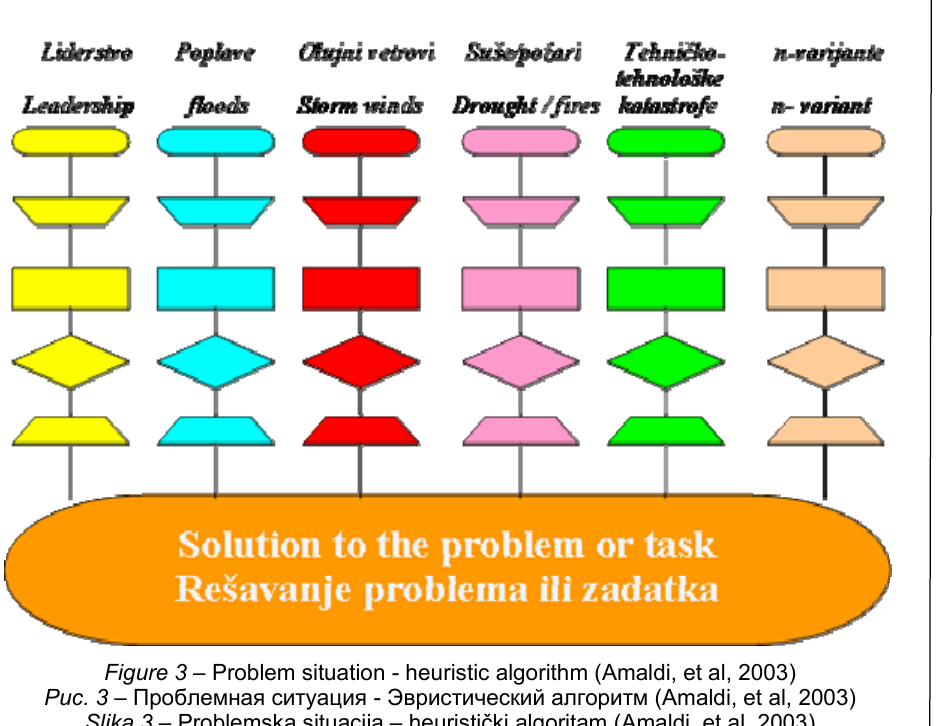
Figure 3 – Problem situation - heuristic algorithm (Amaldi, et al, 2003) Рис . 3 – Проблемная ситуация - Эвристический алгоритм (Amaldi, et al, 2003) Slika 3 – Problemska situacija – heuristi č ki algoritam (Amaldi, et al,